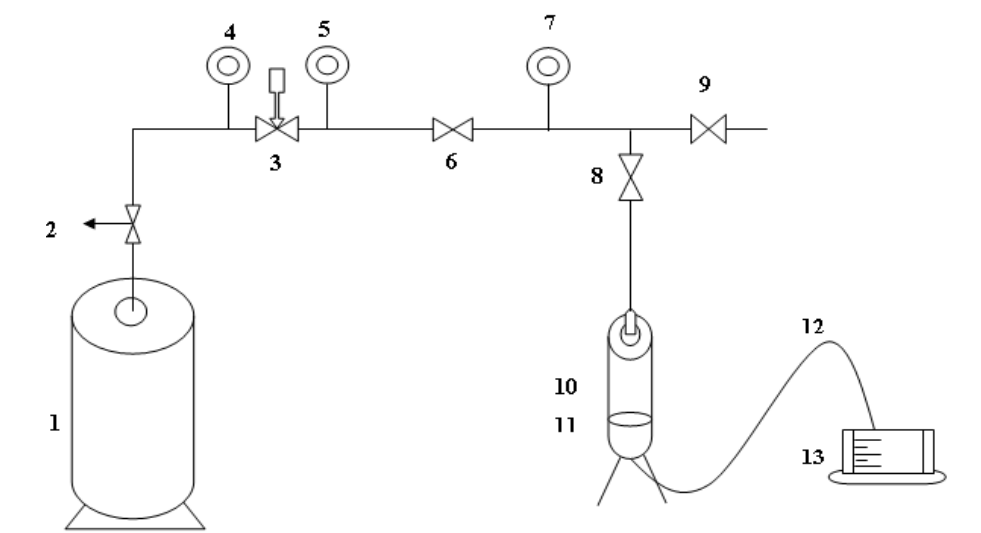
Figure 11. Schematic for experimental setup used for permeation and salt rejection tests. The image includes: N 2 gas cylinder ( 1 ); opening valve ( 2 ); pressure regulator ( 3 ); pressure gauges ( 4 , 5 and 7 ); gas release valve ( 6 ); gas valve towards cylinder ( 8 ); gas purge to outside ( 9 ); permeation module ( 10 ); membrane holder ( 11 ); permeation outlet ( 12 ); and volumetric container ( 13 ).